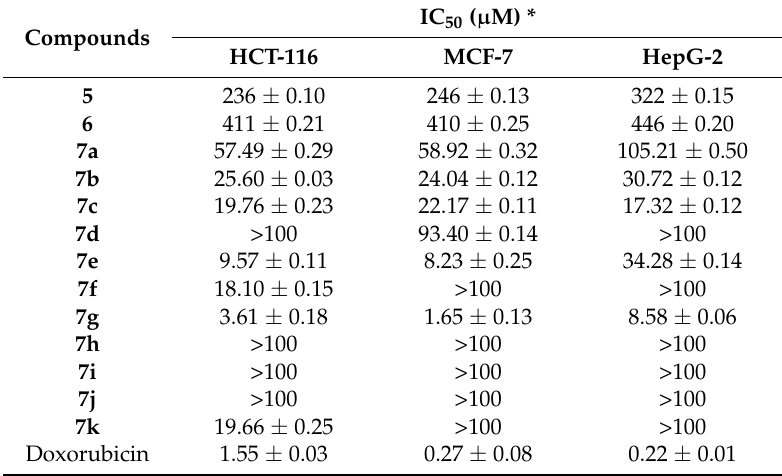
Table 1. Cytotoxicity screening of selected chalcone derivatives against three different cancer cell lines.